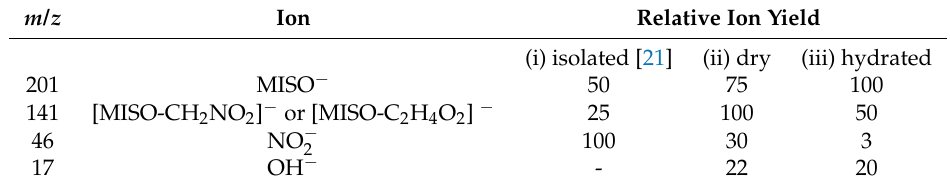
Table 1. Relative ion yields for the main anions observed after electron attachment to MISO integrated over the studied electron energy range. (i) isolated molecule from Ref. [21], (ii) expansion without hydration and (iii) highest hydration conditions. The values are scaled to 100 for the most intense ion yield, m / z = 141 fragment may result from sample impurity. The ion yields at hydrated conditions are sums of yields of anion and its hydrated